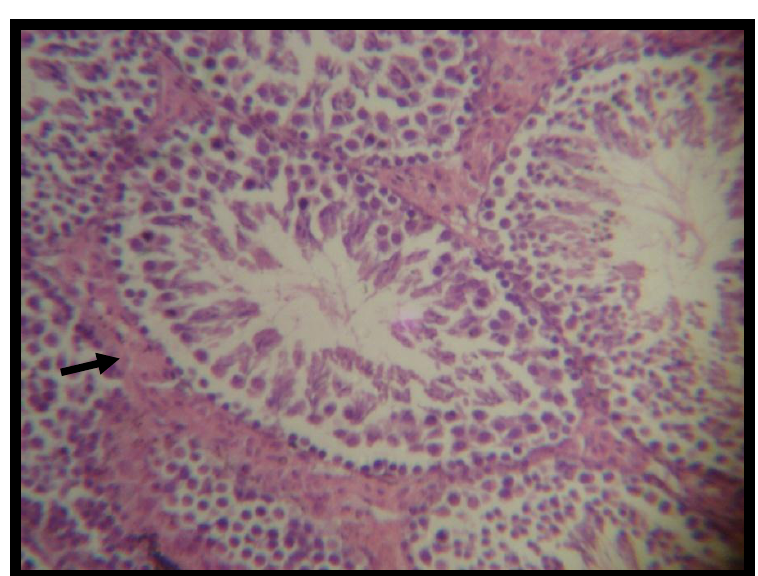
Fig. 4: Histopathological section of testis of the male Mice 30 days post treatment with smut wheat show thickness (  ) of basement membrane due to fibroses (H & E stain